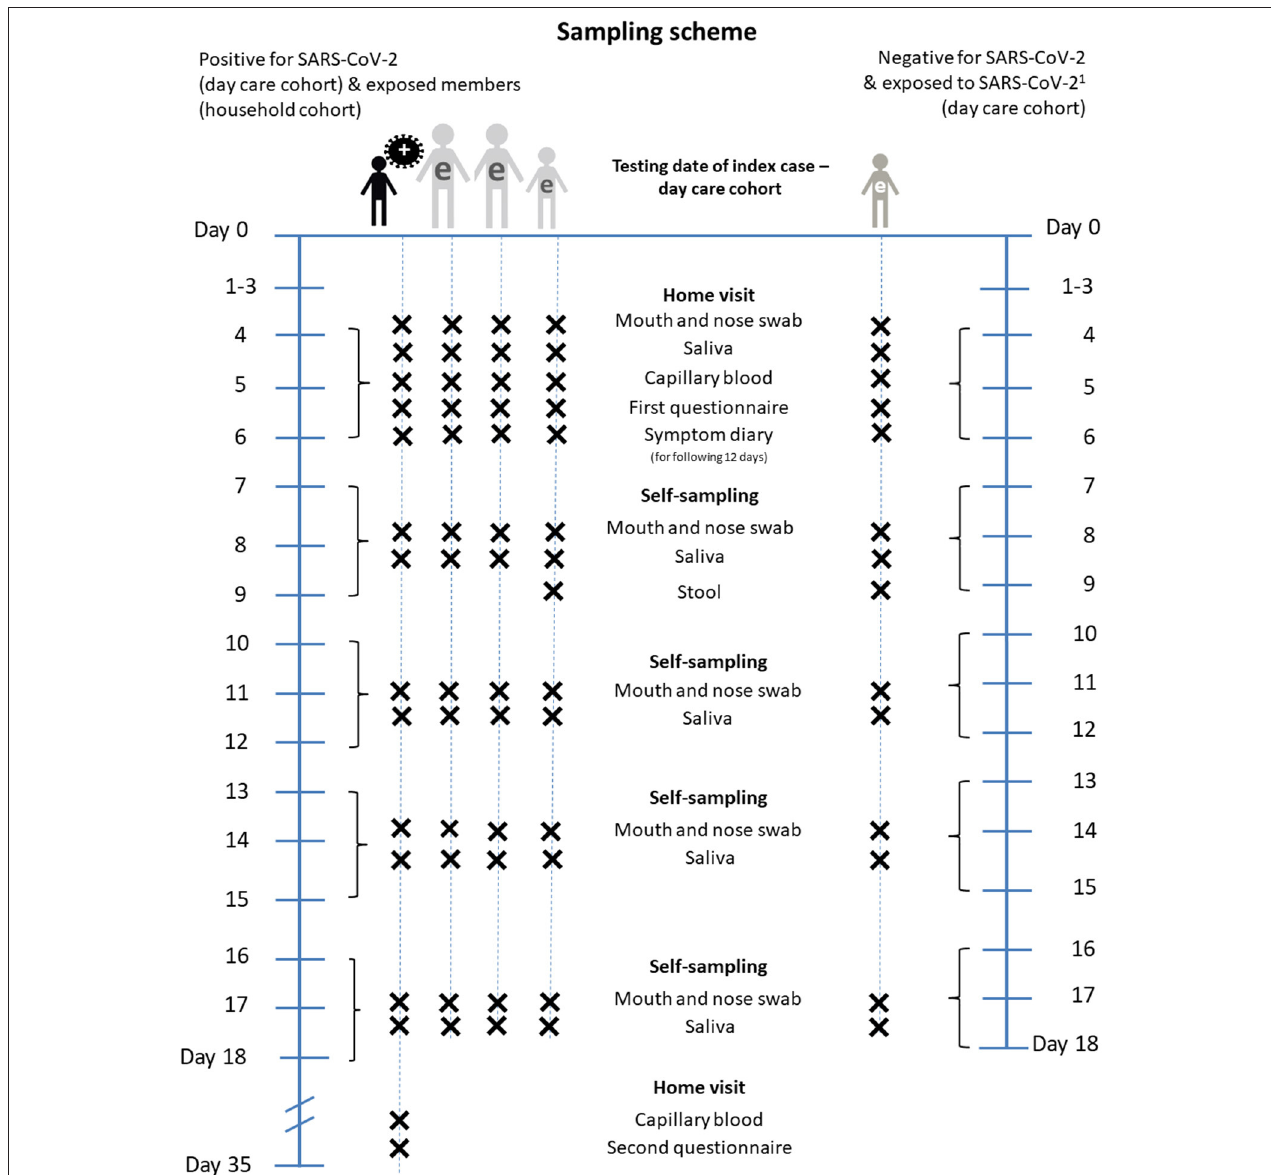
FIGURE 2 | Sampling scheme of COALA. Day 0, testing date of the index case ( = Baseline). e, exposed person. 1 For exposed children and day care personnel newly positive for SARS-CoV-2 until day 13 to 15, the procedure is the same as for initially positive day care personnel and households from day 7 to